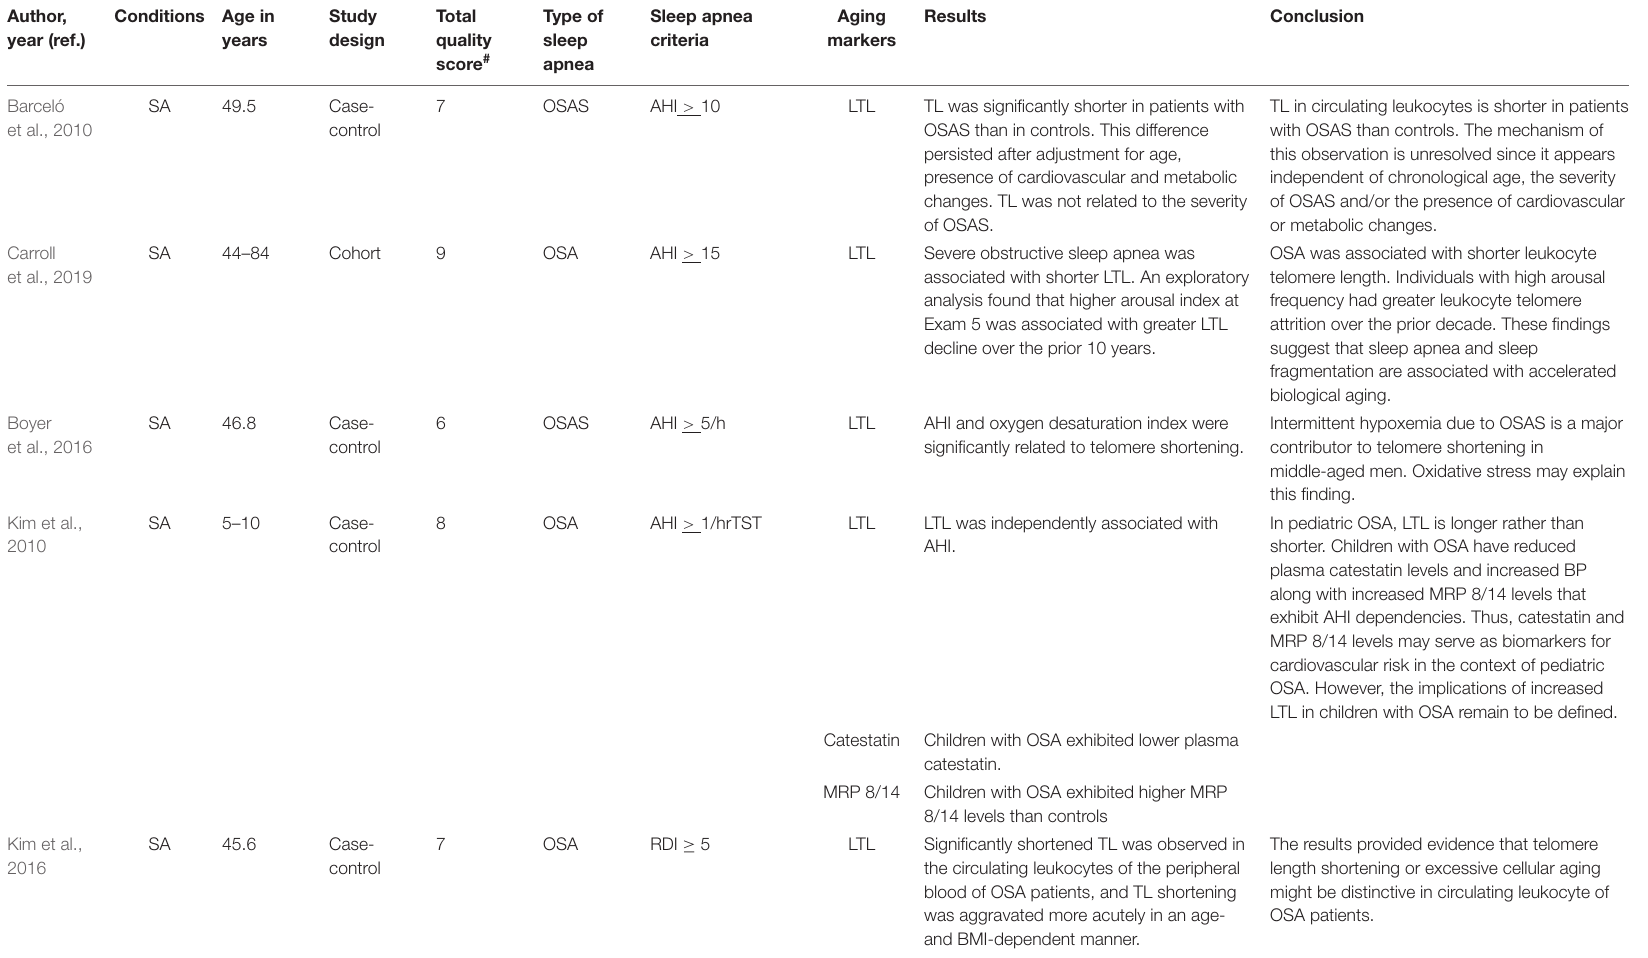
TABLE 5 | The effects of sleep apnea on aging markers (leukocyte telomere length) and age-related diseases. Author, year